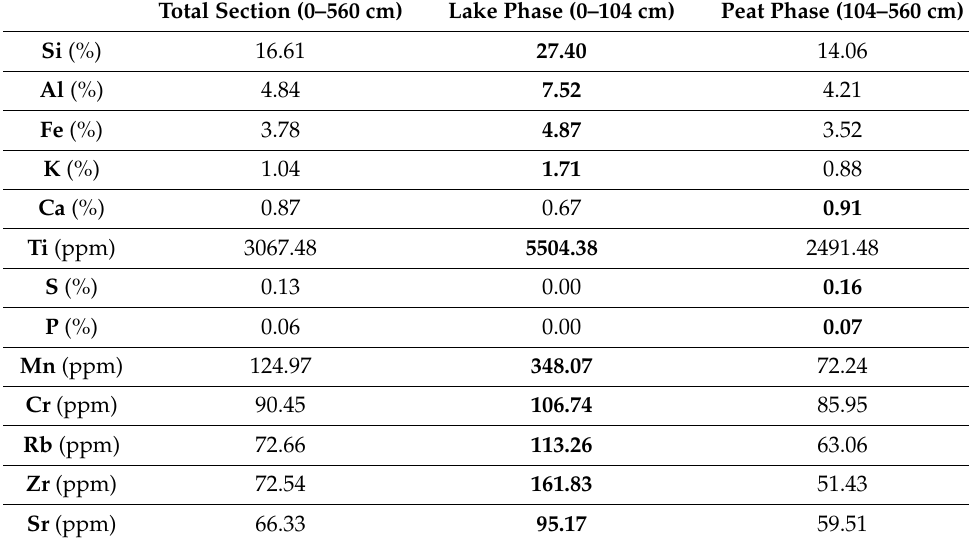
Table 2. Major and trace elements mean concentration in the Round Lake whole section, compared to the lake and the peat phases (the positive deviations from the average concentrations are remarked with bold numbers).